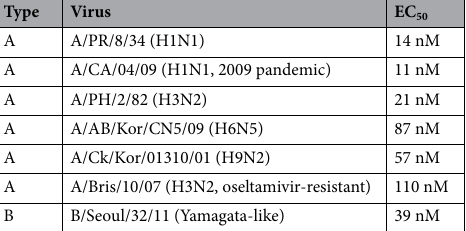
Table 1. Half-maximal effective concentrations (EC 50 ) of aprotinin against various influenza virus strains in Madin–Darby canine kidney (MDCK)